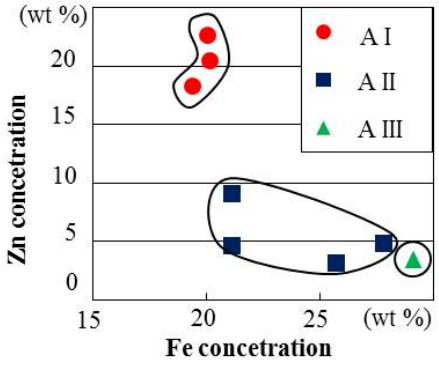
Figure 5. A scattered diagram of Zn/Fe concentrations in each assemblage. AI: assemblage I; AII: assemblage II; AIII: assemblage